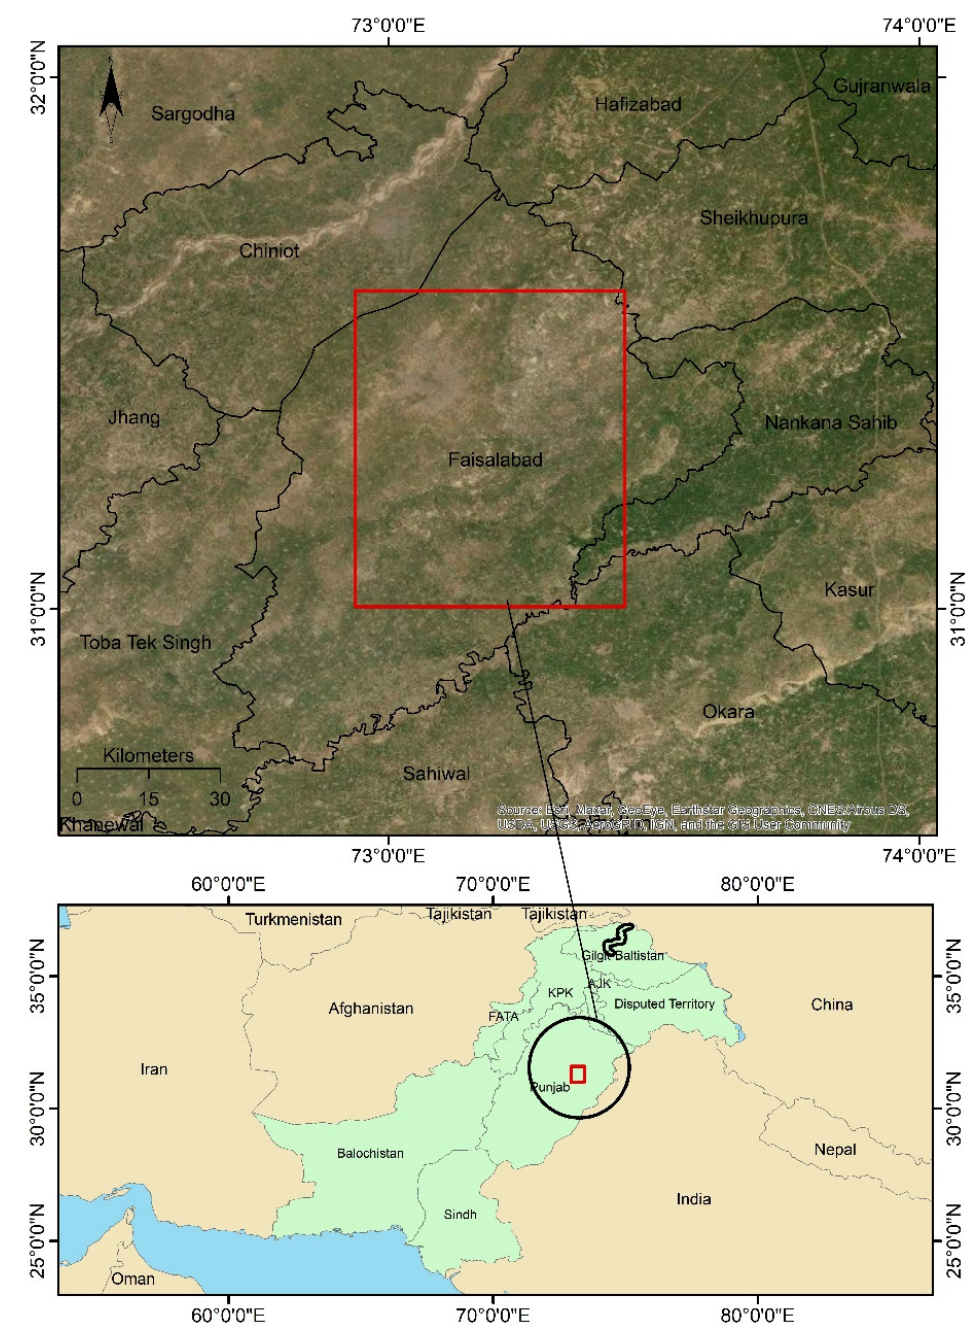
Figure 1. Study area—Faisalabad, Pakistan.